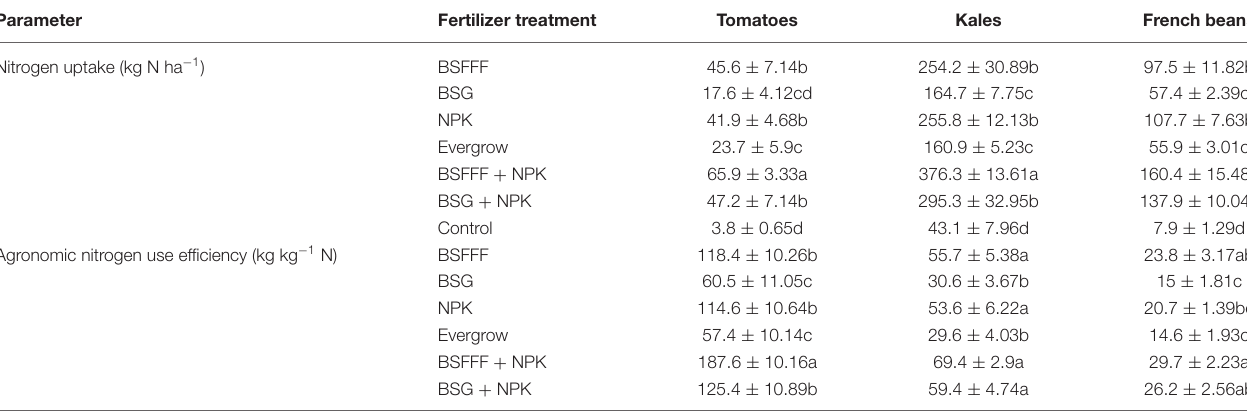
TABLE 6 | Nitrogen uptake and agronomic nitrogen use efficiency of tomatoes, kales, and French beans grown using composted BSF frass, conventionally composted BSG, and commercial fertilizers. Parameter Fertilizer